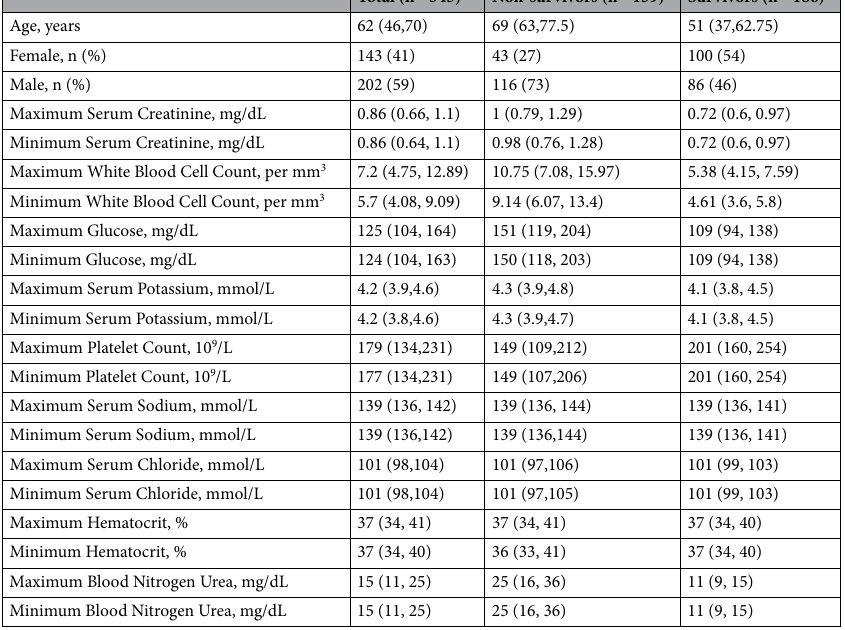
Table 2. Features in the Tongji dataset stratified by survivors and